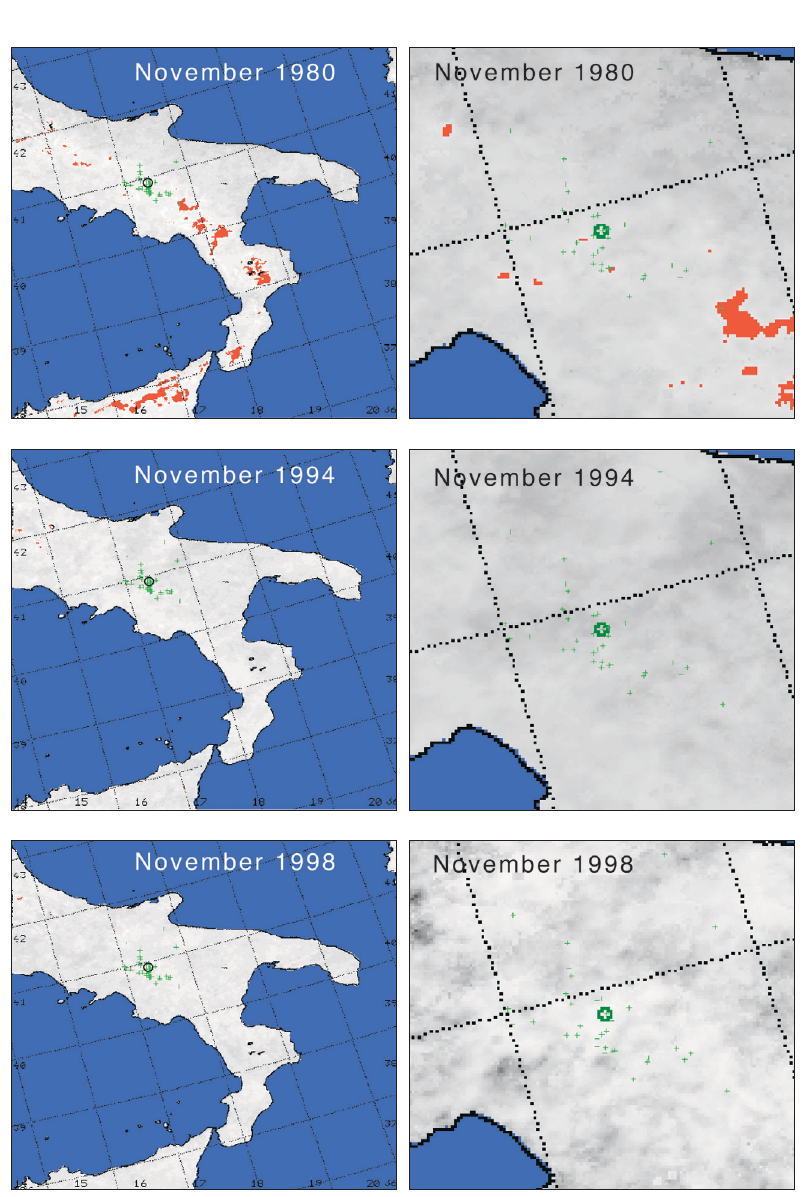
Fig. 5. Results of the analysis on monthly averages ⊗ ∆ LST ( x , y ) of ⊗ ∆ LST ( x , y , t ) index (computed on the ba- sis of NOAA-AVHRR images collected around 18:00 GMT during the months of November from 1994 and 1998) for the month of November 1980, 1994 and 1998 (see text). The aftershocks of the Irpinia-Basilicata earth- quake (November, 23th, 1980, M = 6.9) and the main epicentral area (circled) are depicted in green. Pixels with > 1 are depicted in red. The zooms, on the epicentral area, of images shown on the left are shown ⊗ ∆ LST ( x , y ) on the right side. Note the absence of high ⊗ ∆ LST ( x , y ) values in the unperturbed (no earthquakes with M > 4) month of November 1994 and